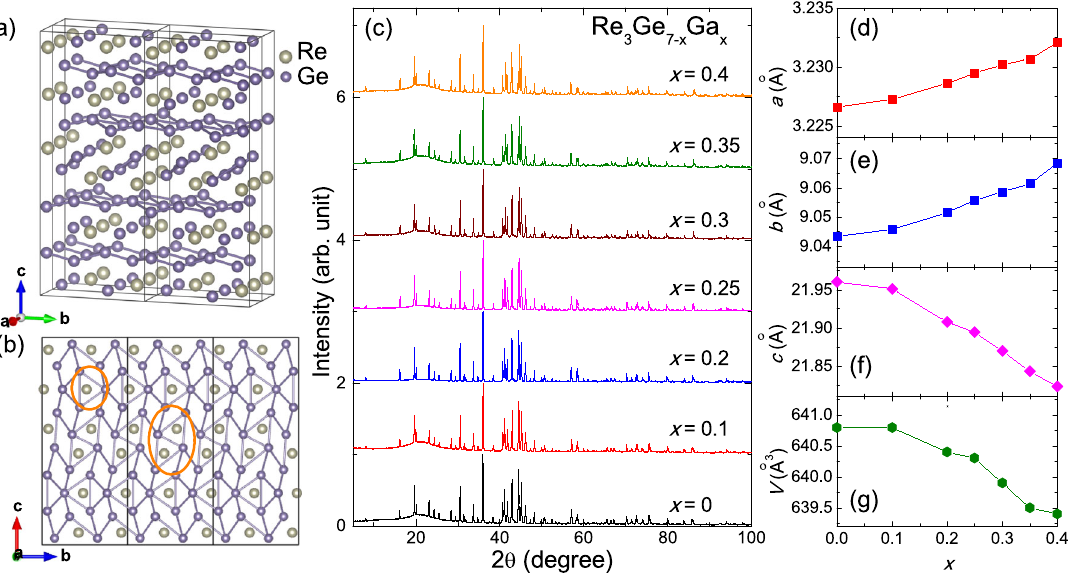
Fig. 1 Schematic crystal structure and x-ray diffraction results of Re 3 Ge 7 − x Ga x . a A three-dimensional view of the orthorhombic structure of Re 3 Ge 7 . b Structure of Re 3 Ge 7 projected perpendicular to the a -axis. The circles indicate the ReGe 3 and Re 2 Ge 4 building blocks. c Room temperature powder XRD patterns for the series of Re 3 Ge 7 − x Ga x samples. d – g Variation of a -, b -, c -axis lattice parameters and unit-cell volume of Re 3 Ge 7 − x Ga x as a function of the Ga content x .